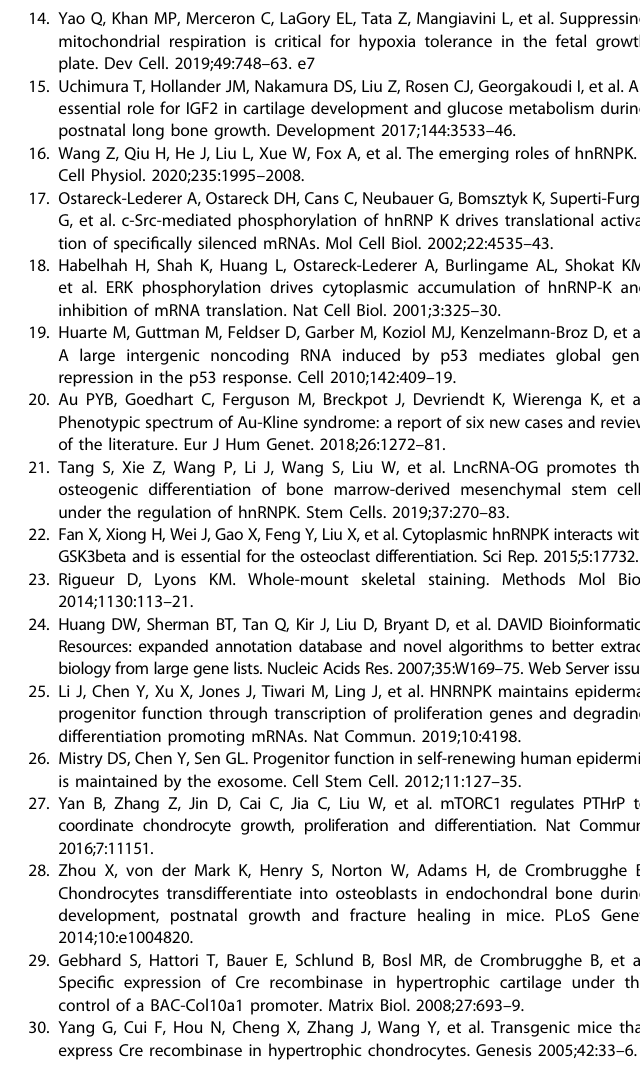
Fig. 7 Diagram of Hnrnpk orchestrating growth plate development. During growth plate development, Hnrnpk bound to the Hif1a mRNA and mediated its degradation. Ablating Hnrnpk in chondrocytes resulted in the increased expression of Hif1 α and then the increased expression of downstream target genes including Ldha and Pfkfb3. The elevated level of glycolytic enzymes led to excessive glycolysis and fi nally abnormal growth plate